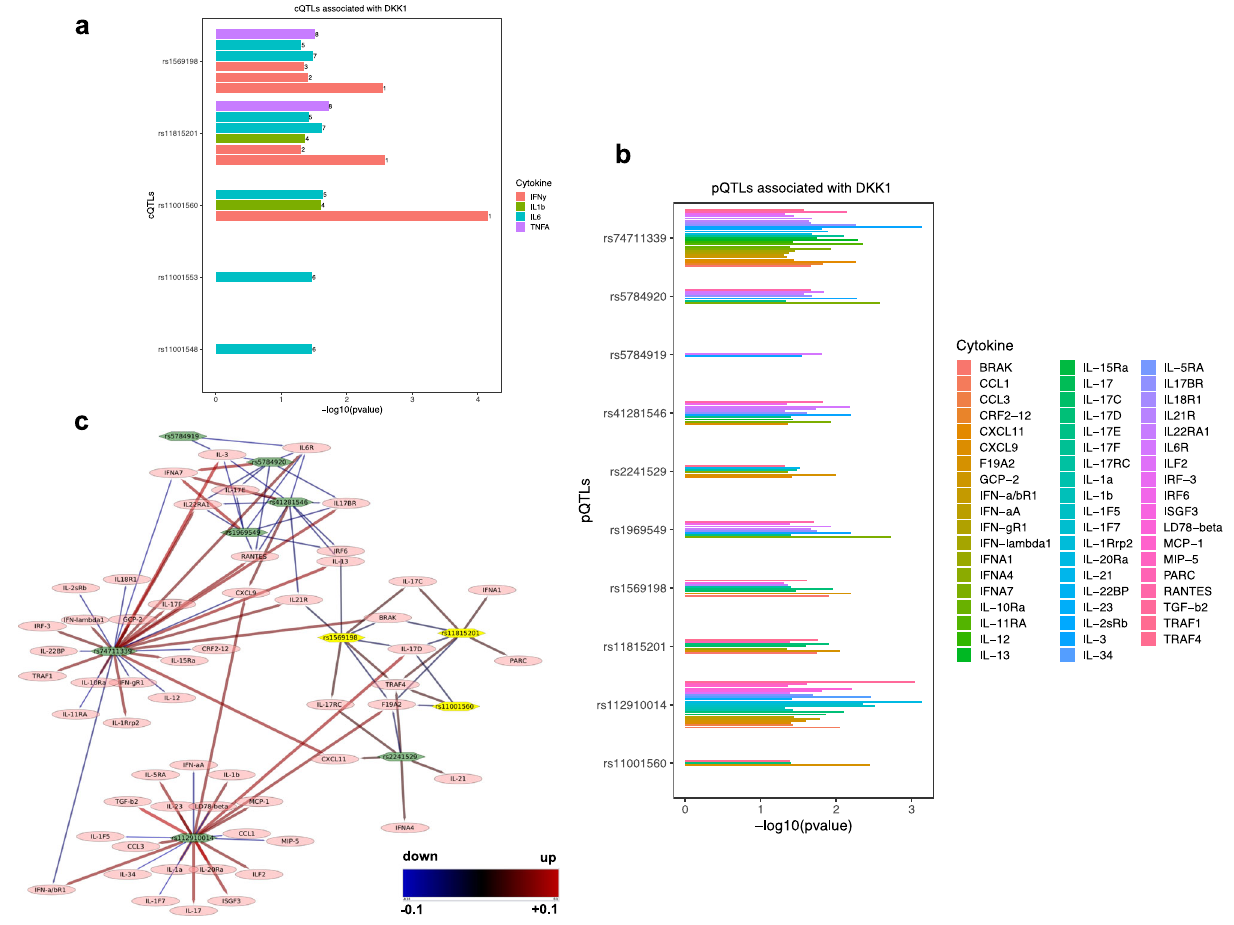
Fig. 5 Genetic DKK1 variants are linked to boosted cytokine production in humans. a Associations between genetic DKK1 variants and cytokine expression in response to infectious triggers (cytokine quantitative trait loci, cQTLs) from the 500FG study. The numbers shown on the top of the bars correspond to distinct experimental setups used in the original study 29 (see Supplementary Data 1). b Associations between genetic DKK1 variants (protein quantitative trait loci; pQTLs) and the expression of various cytokines from an independent human cohort 30 . Log-transformed p values are shown. c A bipartite network depiction of the DKK1-associated pQTLs and various cytokines/chemokines. Green hexagonal nodes depict pQTLs, whereas cytokines are visualized as pink ovals. Positive associations (DKK1 variants linked to increased cytokine expression) are visualized in red and negative associations (reduced cytokine expression) in blue with color gradations in between. Effect sizes are highlighted by the thickness of the respective arrows. DKK1 variants shared between the two study populations are highlighted in